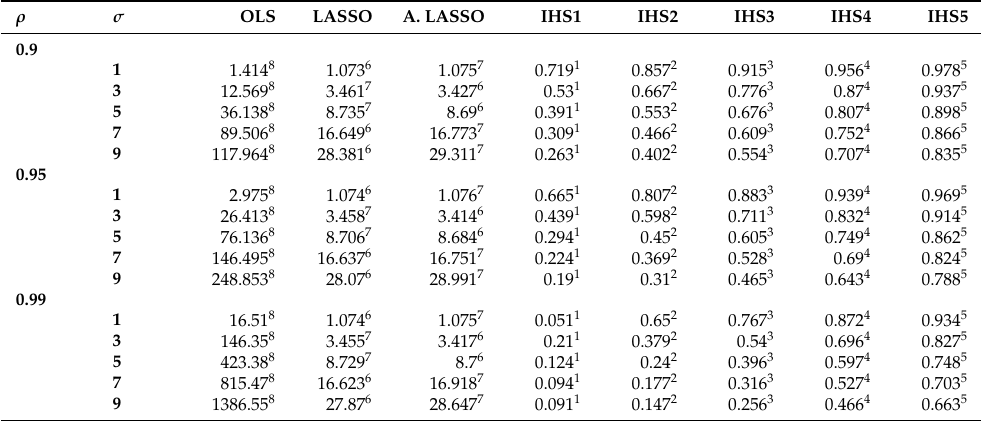
Table 8. Estimated MSEs for n = 100 and p = 16 (superscript represents ranking).